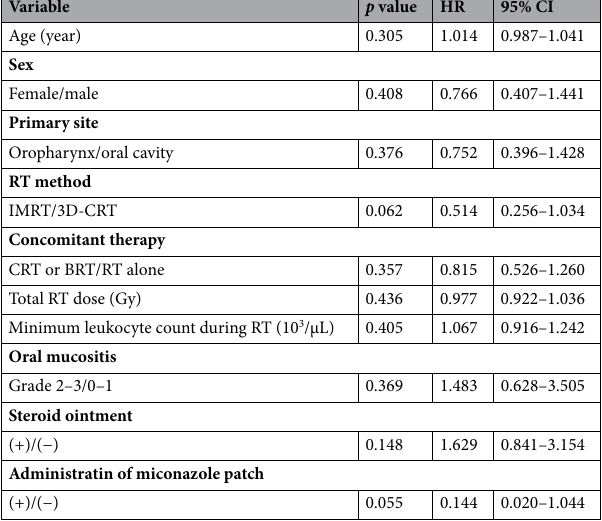
Table 2. Factors related to the development of oral candidiasis (univariate cox regression analysis).